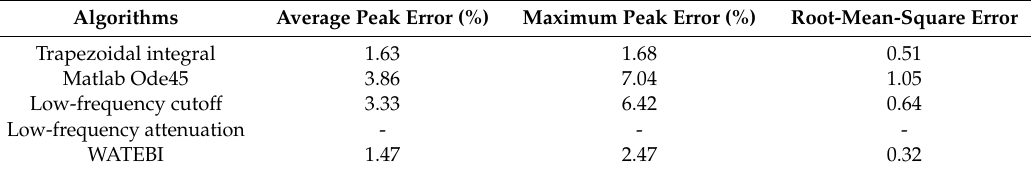
Figure 8. Velocity of El Centro ground motion: ( a ) Full duration; ( b ) Enlarged detail at largest trough. Table 3. Five methods for the velocity reconstruction of El Centro event.